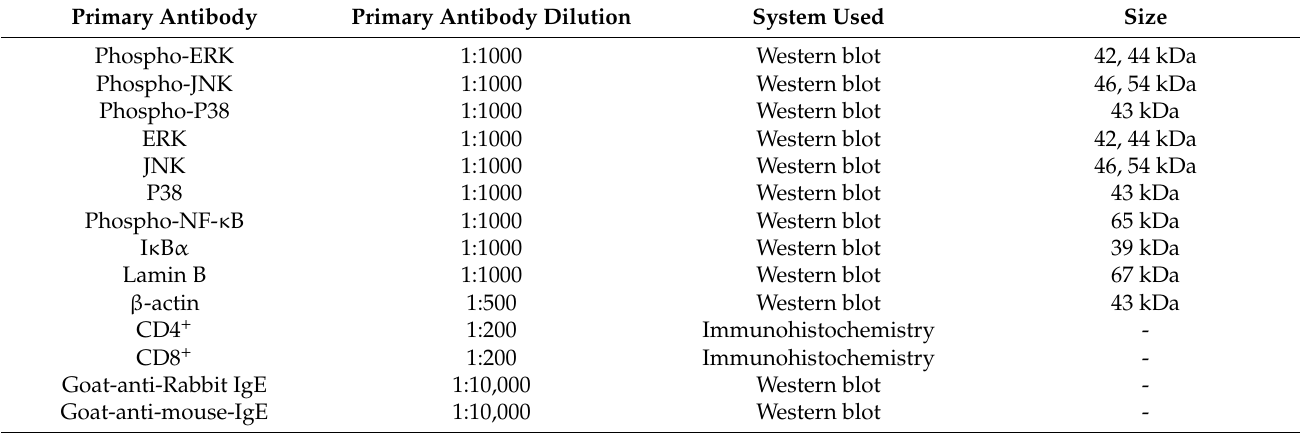
Abbreviations: Phospho, Phosphorylation; ERK, extracellular signal-regulated kinases; JNK, c-Jun N-terminal kinase; NF- κ B, nuclear factor-kappa B; I κ B α , nuclear factor of kappa light polypeptide gene enhancer in B-cells inhibitor alpha; cluster of differentiation 4, CD4; cluster of differentiation 8, CD8; IgE, Immunoglobulin